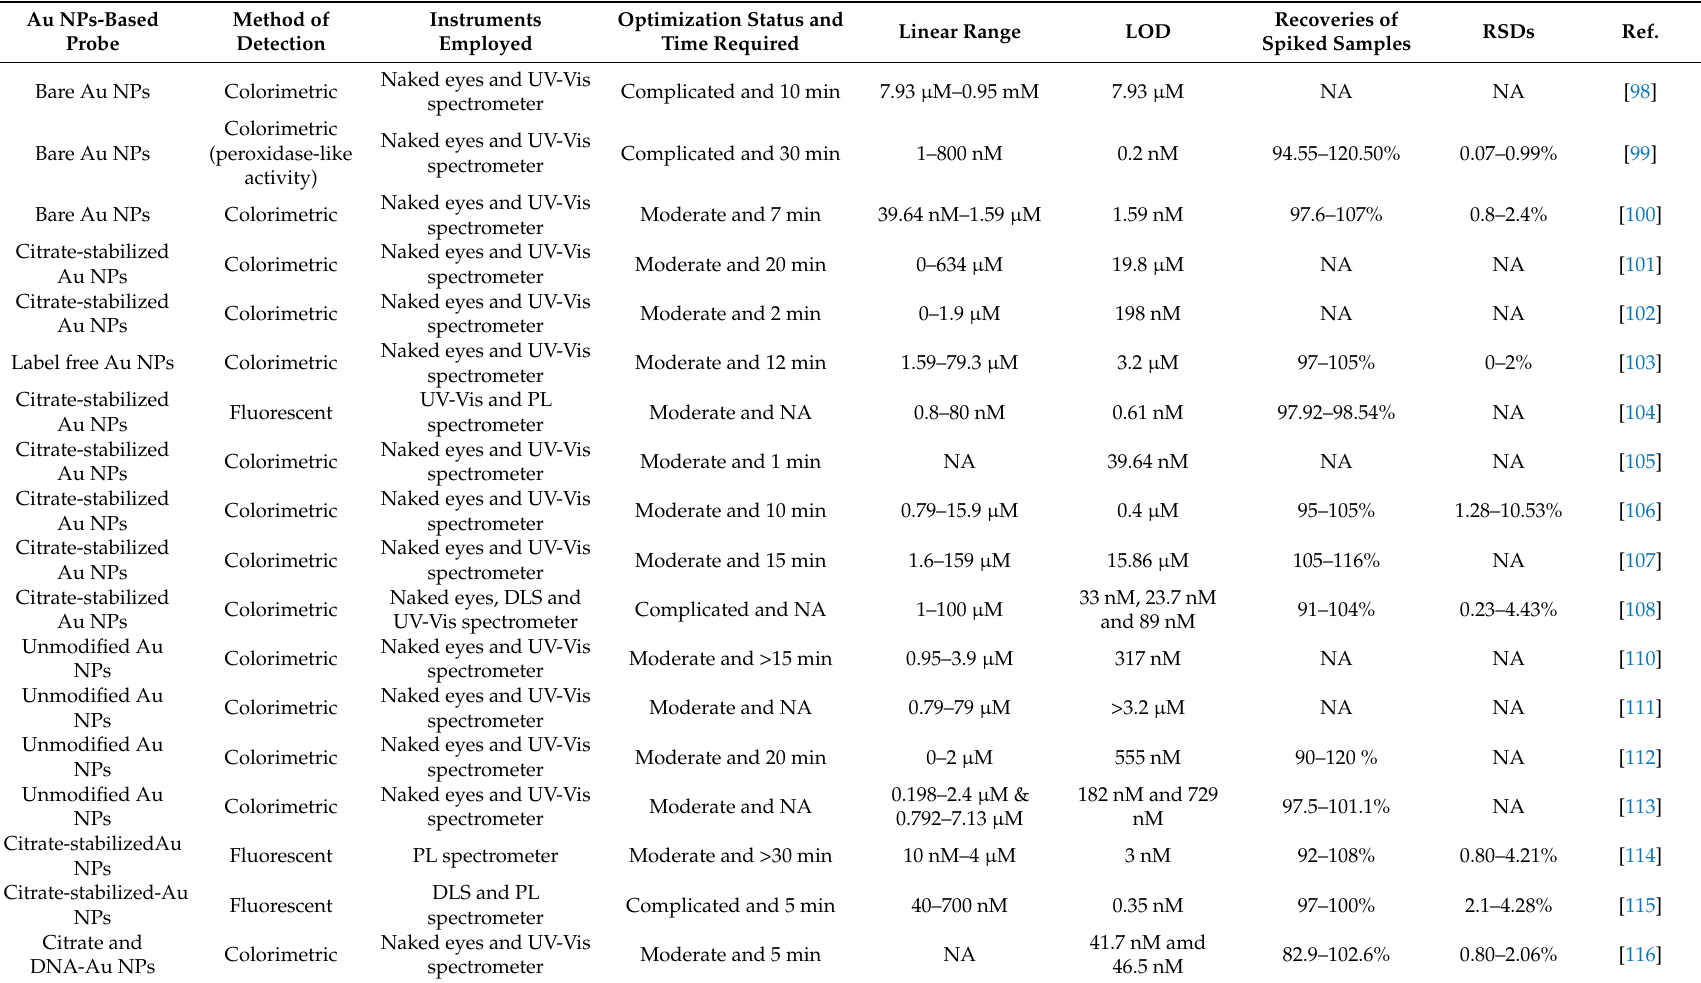
Table 1. Summary of methods, instruments, optimization status, time, linear ranges, detection limits (LODs), recoveries and relative standard deviations (RSDs) of Au NPs-based probes in melamine